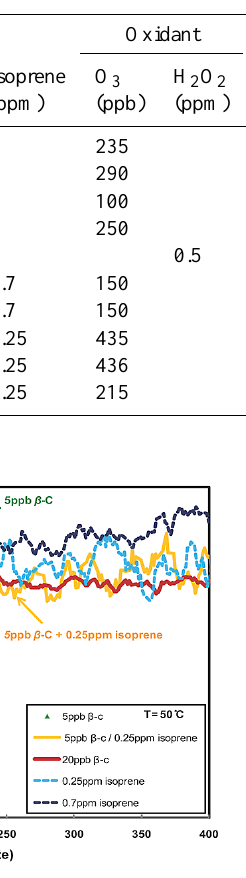
Table 1. Experimental conditions without OH scavenger.